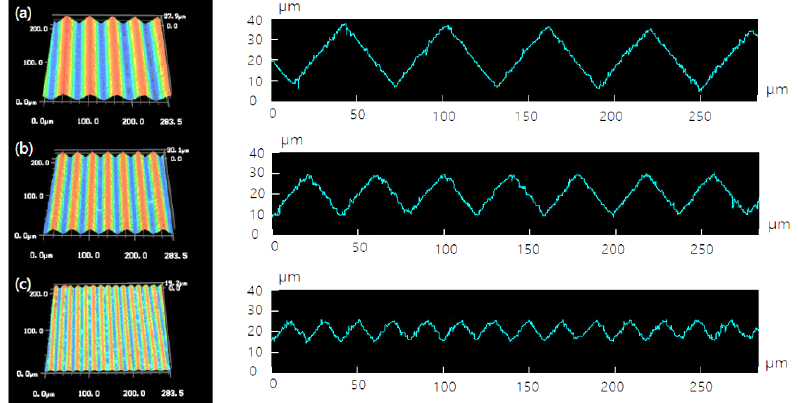
Figure 5. Confocal microscopy images of the dip ‐ coated surface on the patterned polymer substrate with ( a ) 10 μ m, ( b ) 20 μ m, and ( c ) 30 μ m depths.